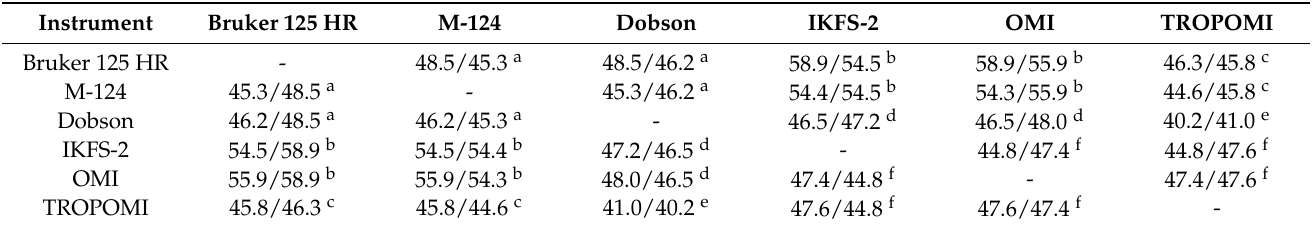
Table 4. Natural TOC variability in DU for all observation data near St. Petersburg for time spans in the 2004–2020 period (as a standard deviation of the mean) in DU; letters in cells mark different time spans in which the data are compared (a: 2009–2020, b: 2015–2020, c: 2018–2020, d: